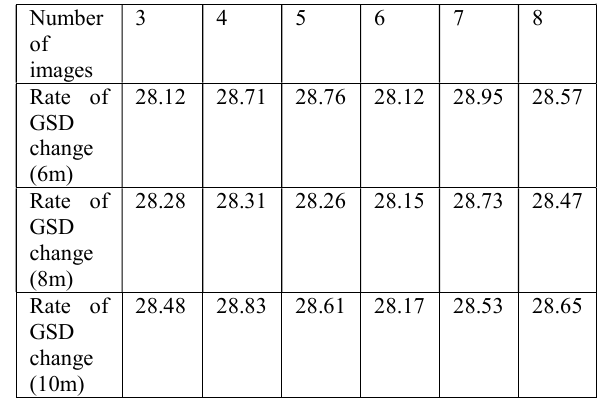
Table 3. Critical values of rate of GSD change for all sets